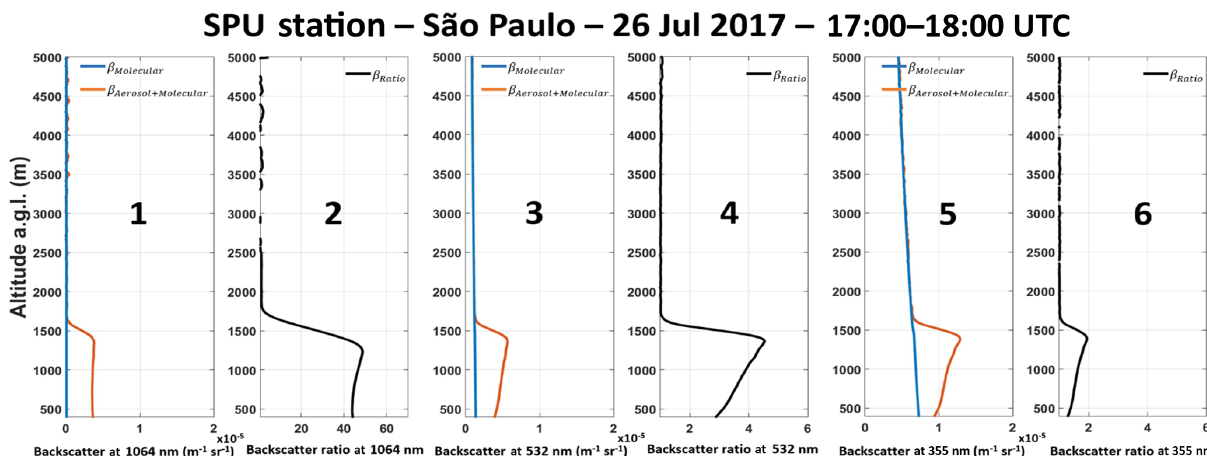
Figure 7. Total (aerosol and molecular) backscatter profile and backscatter ratio retrieved using the Klett–Fernald–Sasano inversion technique for 1064, 532 and 355nm, respectively, for data retrieved on 26 July 2017 at 17:00–18:00UTC by the SPU lidar system.